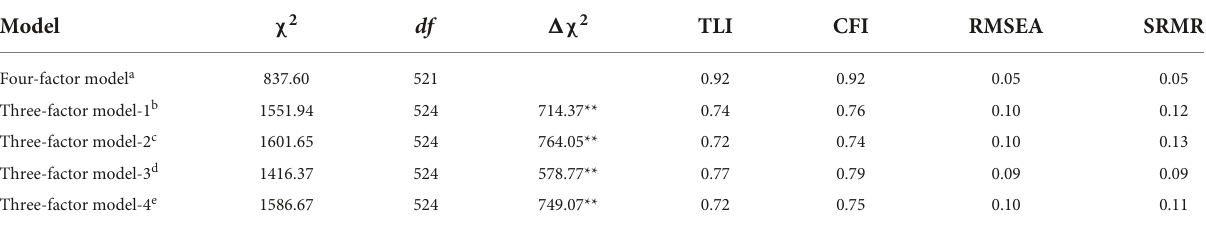
TABLE 2 Results of confirmatory factor